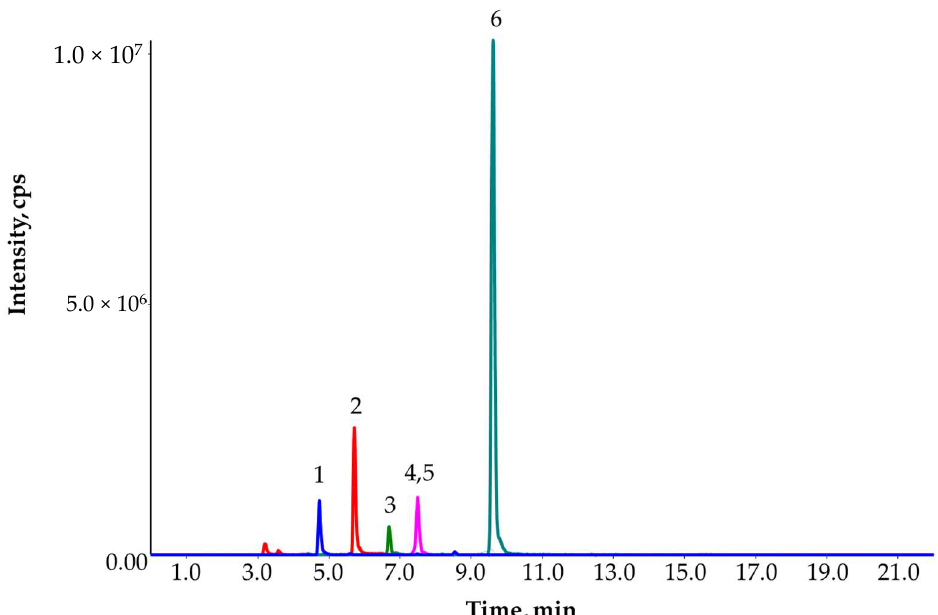
Figure 5. Extracted ion chromatogram of the first PT sample containing: desizopropyl atrazine (1), desethyl atrazine (2), simazine (3), metazachlor (4), atrazine (5) and metolachlor (6). The metazachlor (4) and atrazine (5) completely co-eluted in the chromatogram with the same intensity. However, the